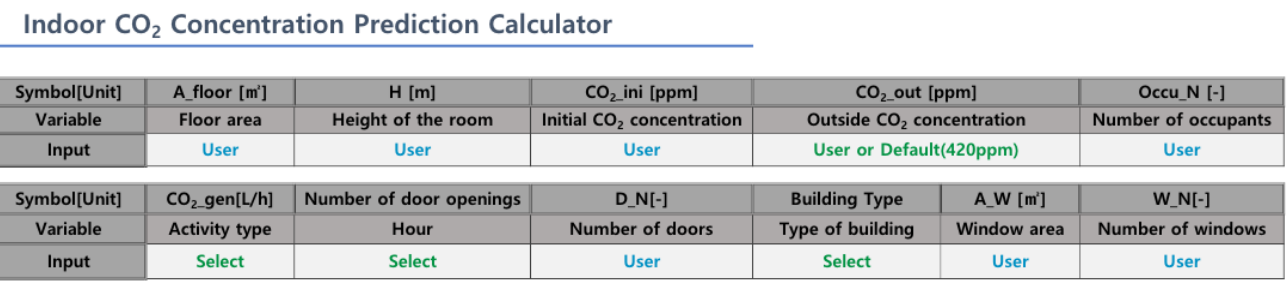
Figure 9. Input parameters for the office indoor CO 2 concentration prediction calculator.